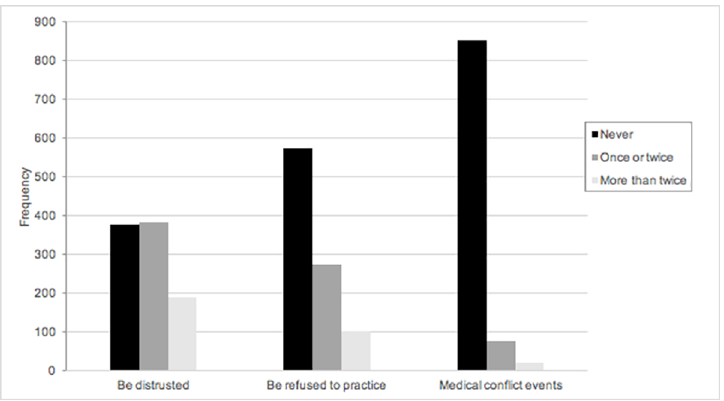
Fig 1. Adverse events that medical students had encountered in the past 6